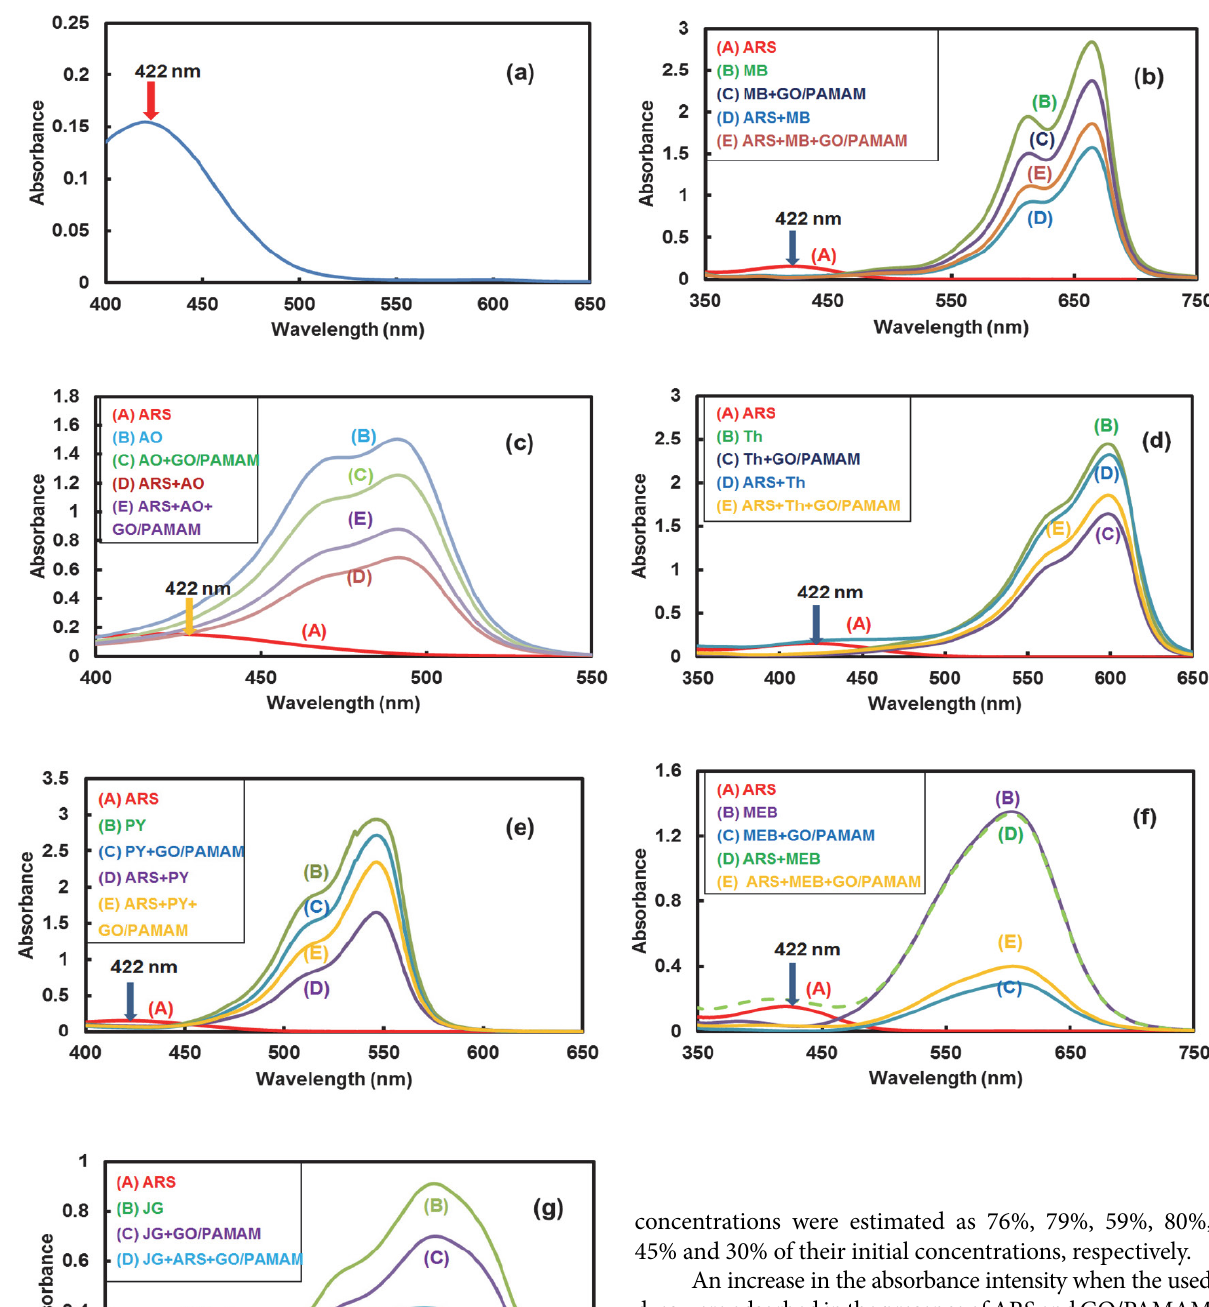
Figure 14. (a) Absorption peak of ARS at pH = 2. In all solutions, concentration of ARS was 5 × 10 –2 mM and those of MB in (b), AO in (c), Th in (d), PY in (e) and MEB in (f) were 5 × 10 –2 mM and concentration of JG in (g) was 2.5 × 10 –2 mM. Tests were carried out at pH = 2 and room temperature. In curves (C) and (E) of all figures the weight of used GO/PAMAM was 0.001